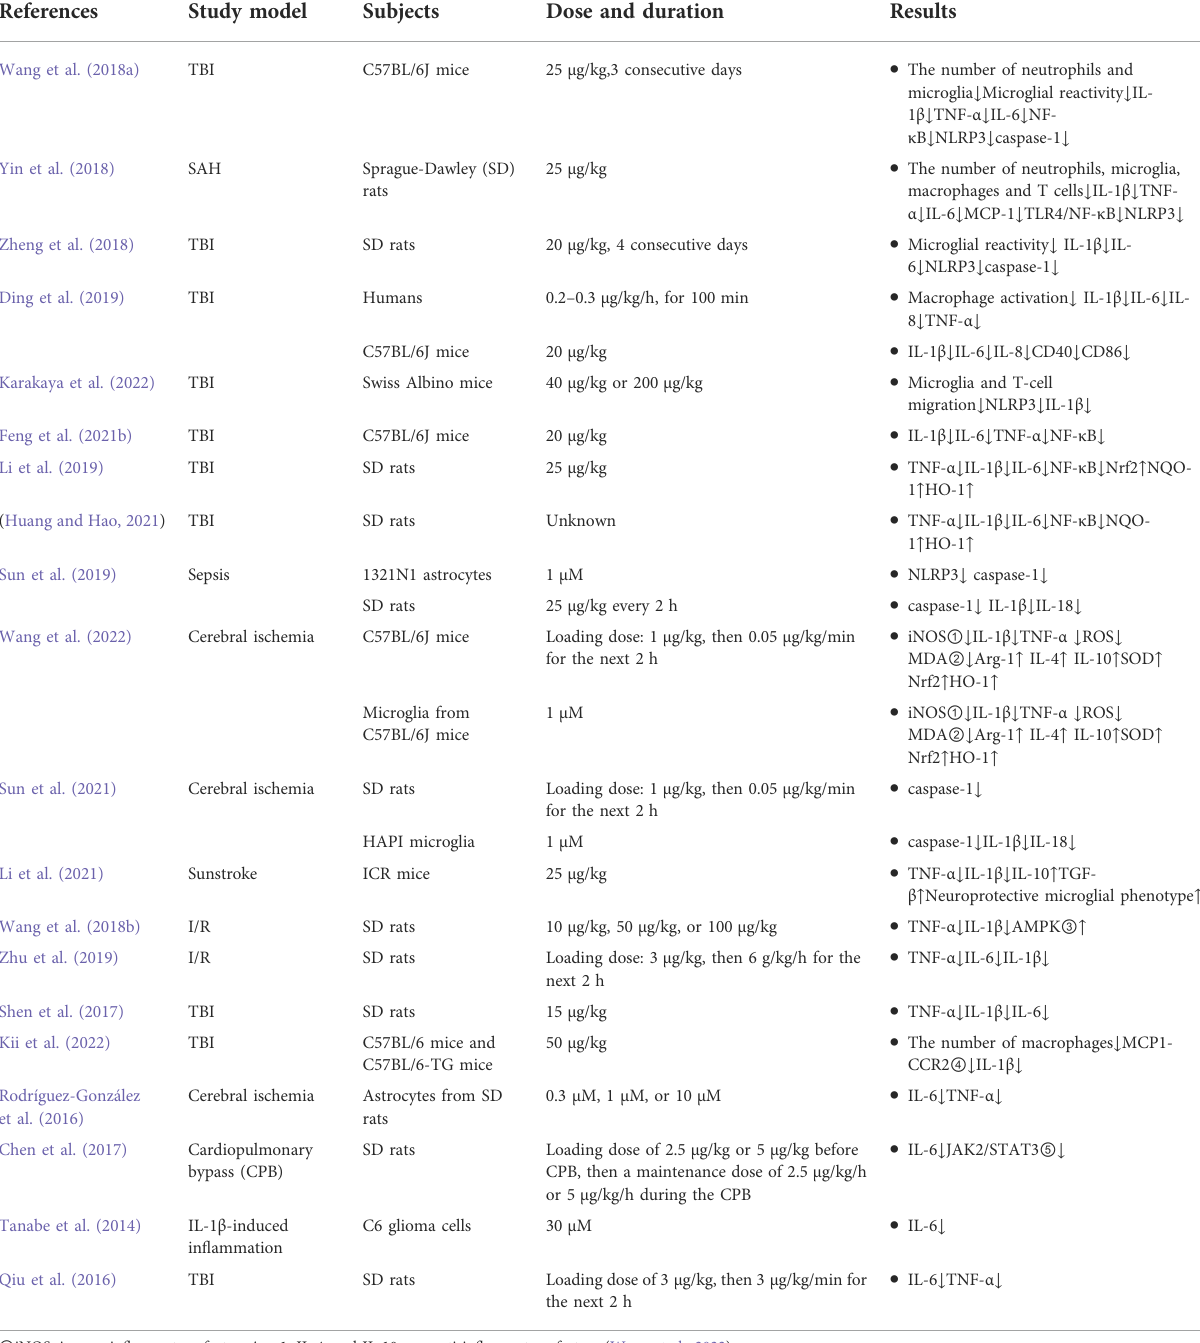
TABLE 1 Changes in various in fl ammatory mediators and